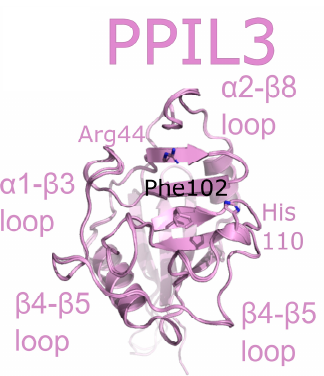
Figure 8. PPIL3 is shown in cartoon representation (PDB IDs: 2XWN and 2OK3). Selected catalytic residues and protein–protein interaction regions are labeled.